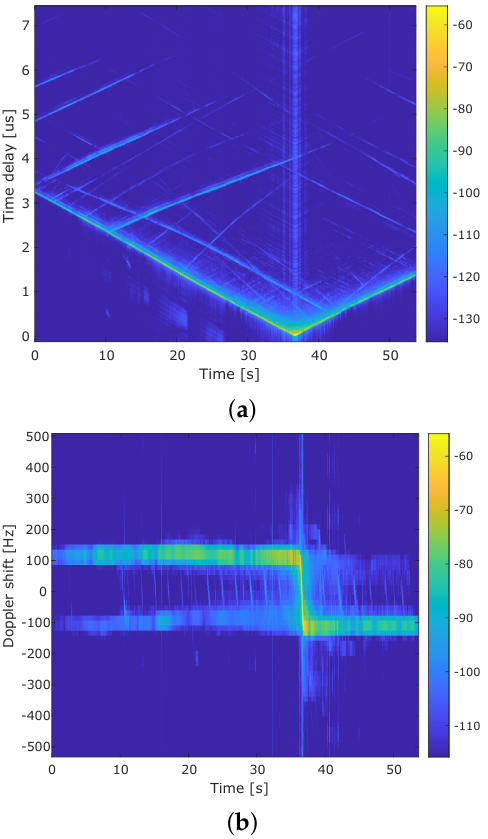
Figure 2. Time-varying ( a ) Power Delay Profile (PDP) and ( b ) Doppler Power Profile (DPP) for the scenario of crossing Tx at the known position with a constant speed of 90 km/h